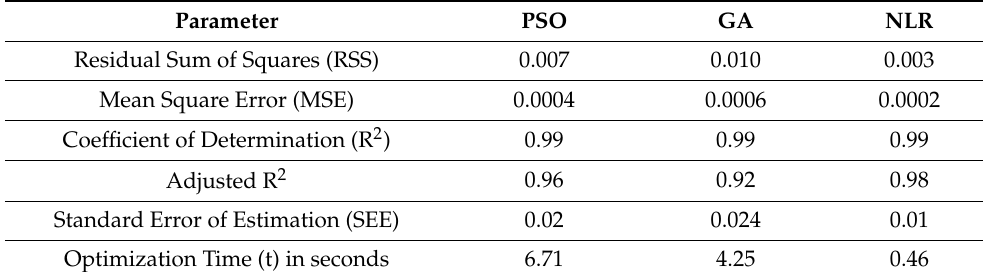
Table 5. Estimation statistics for MAP